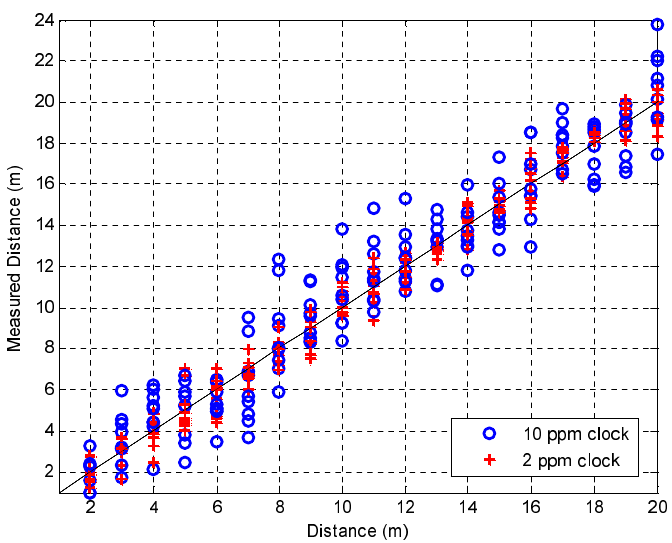
Figure 12. Measured distance for clock deviation.